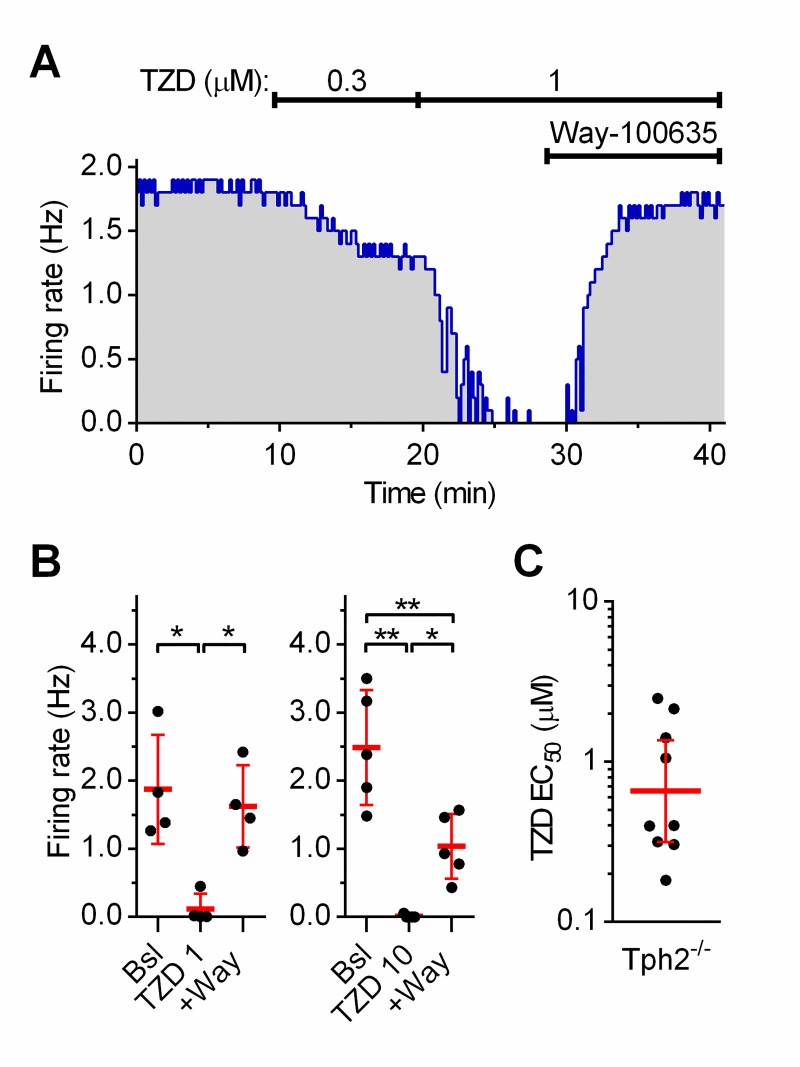
Effect of trazodone in Tph2-/- mice.(A) Representative recording of concentration-dependent effect of trazodone (TZD). The effect was fully antagonized by 20 nM Way-100635. (B) Summary of the antagonism exerted by 20 nM Way-100635 (+Way) on responses to 1 μM (n = 4; One-way RM ANOVA: F(2,3) = 36.24; p <0.0045) and 10 μM (n = 5; One-way RM ANOVA: F(2,4) = 41,95; p <0.0028) trazodone. Note the partial antagonism of responses to 10 μM trazodone. (C) Scatter plot of the individual EC50 values calculated from all experiments (n = 9). Red line and error bars indicate the geometric mean and 95% C.I.. The activity of serotonergic neurons was facilitated by the presence of 10 μM PE. * p < 0.05; ** p < 0.01 (One-way RM ANOVA, followed by a Tukey post-hoc test).